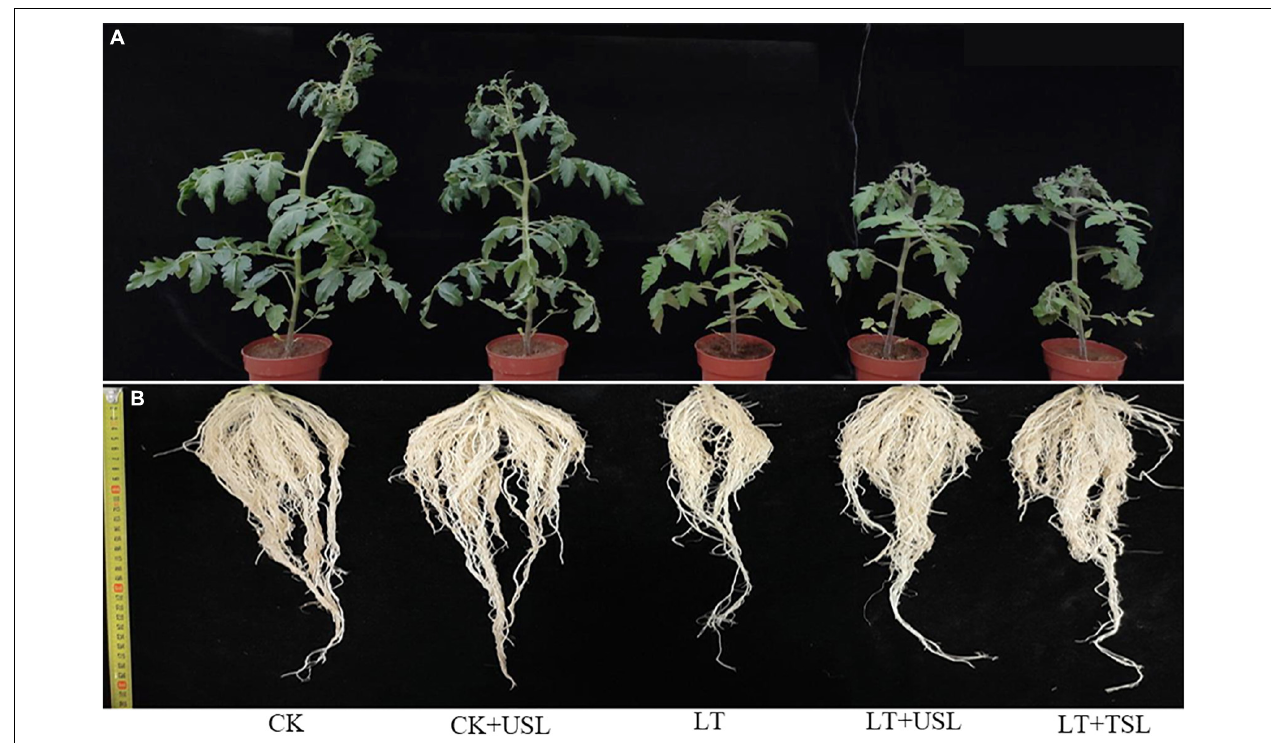
FIGURE 1 | Phenotypic observation of the aboveground (A) and underground (B) morphology of tomato seedlings under low temperature (LT) stress with light supplementation from underneath the canopy. CK, seedlings under natural temperature; CK + USL, seedlings under natural temperature with supplemental lighting from underneath the canopy; LT, seedlings under sub-LT; LT + USL, seedlings under sub-LT with supplemental lighting from underneath the canopy; and LT + TSL, seedlings under sub-LT with supplemental lighting from above the canopy.